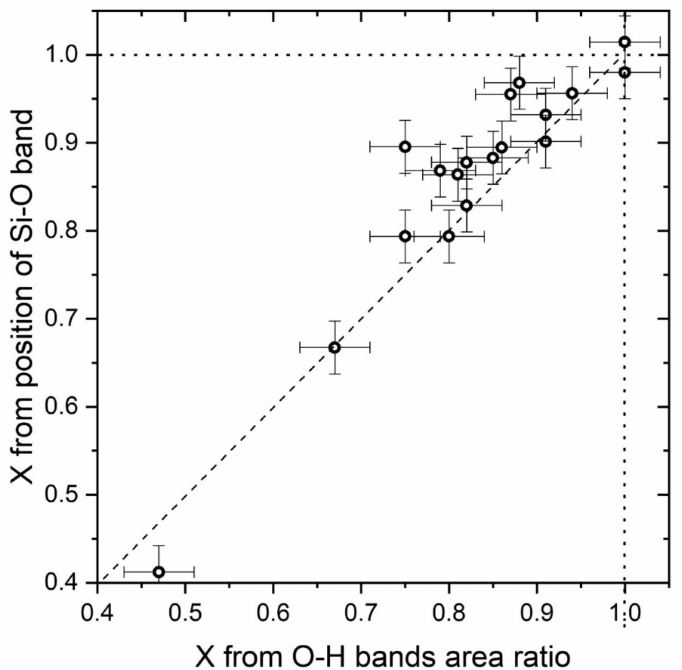
Figure 6. Comparison between the X values obtained starting from the position of the main Raman band at nearly 670 cm − 1 and from the area ratio of the OH Raman stretching bands. The dashed lines (for X = 1.0 and for equal values) are drawn for visual